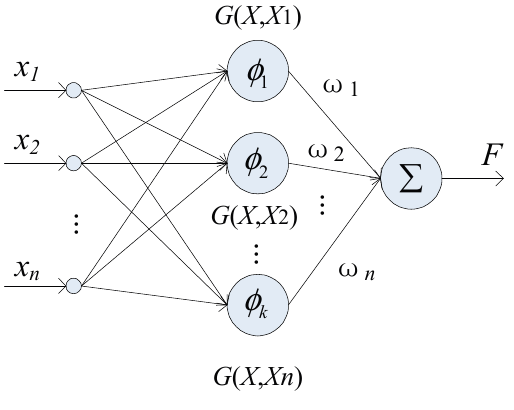
Figure 6. The structure of the regularization